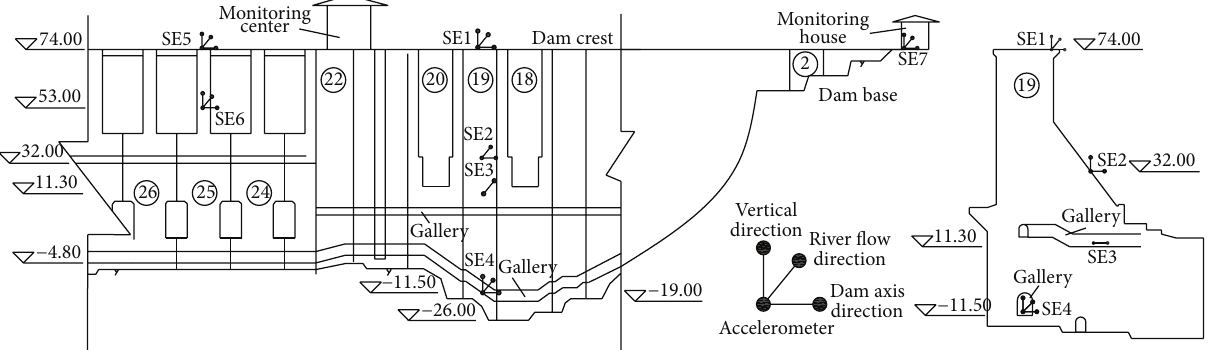
Figure 8: Arrangement of